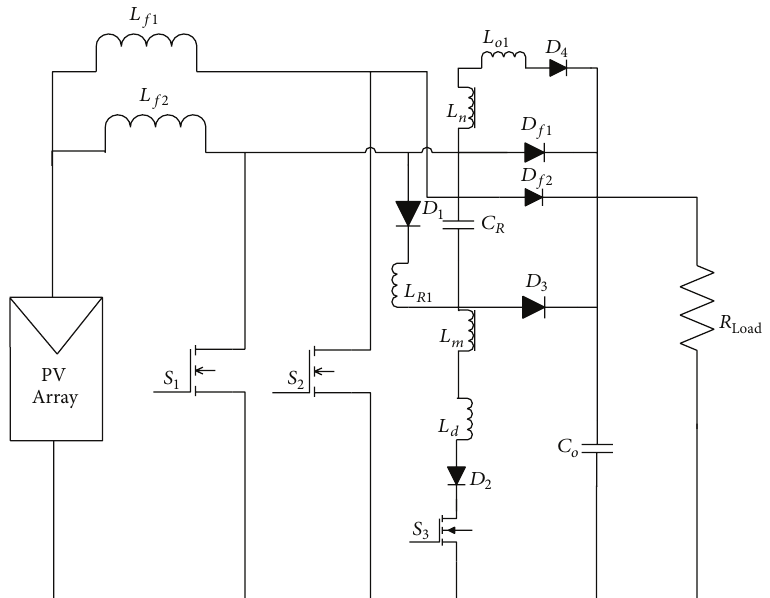
Figure 12: Circuit diagram of PV based parallel boost converter with active snubber with resistive load.